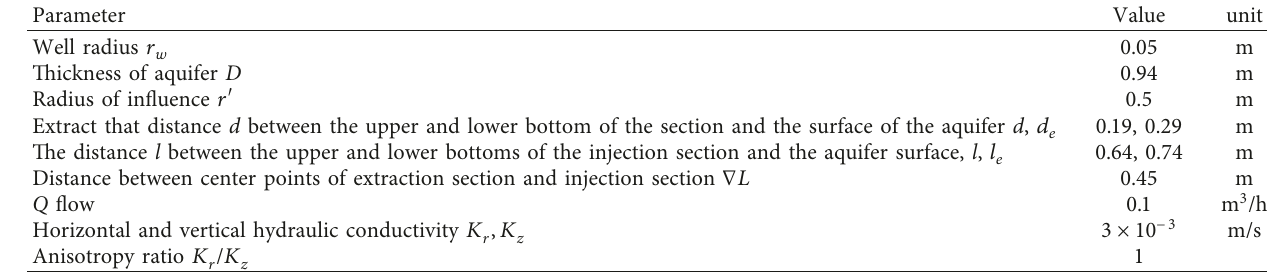
Table 1: Value list of model